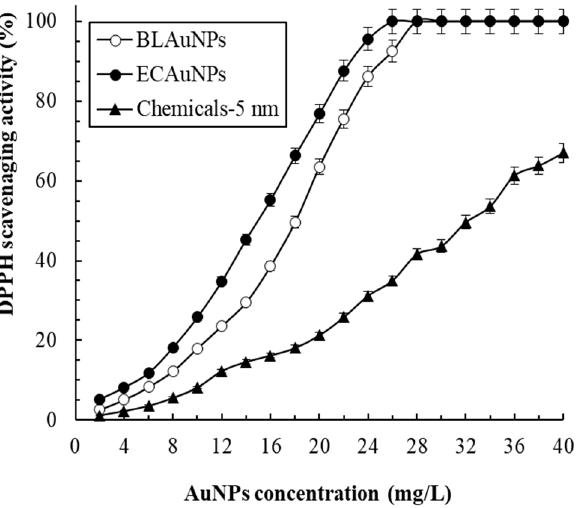
Figure 3 . DPPH radical scavenging activity of BLAuNPs, ECAuNPs, and